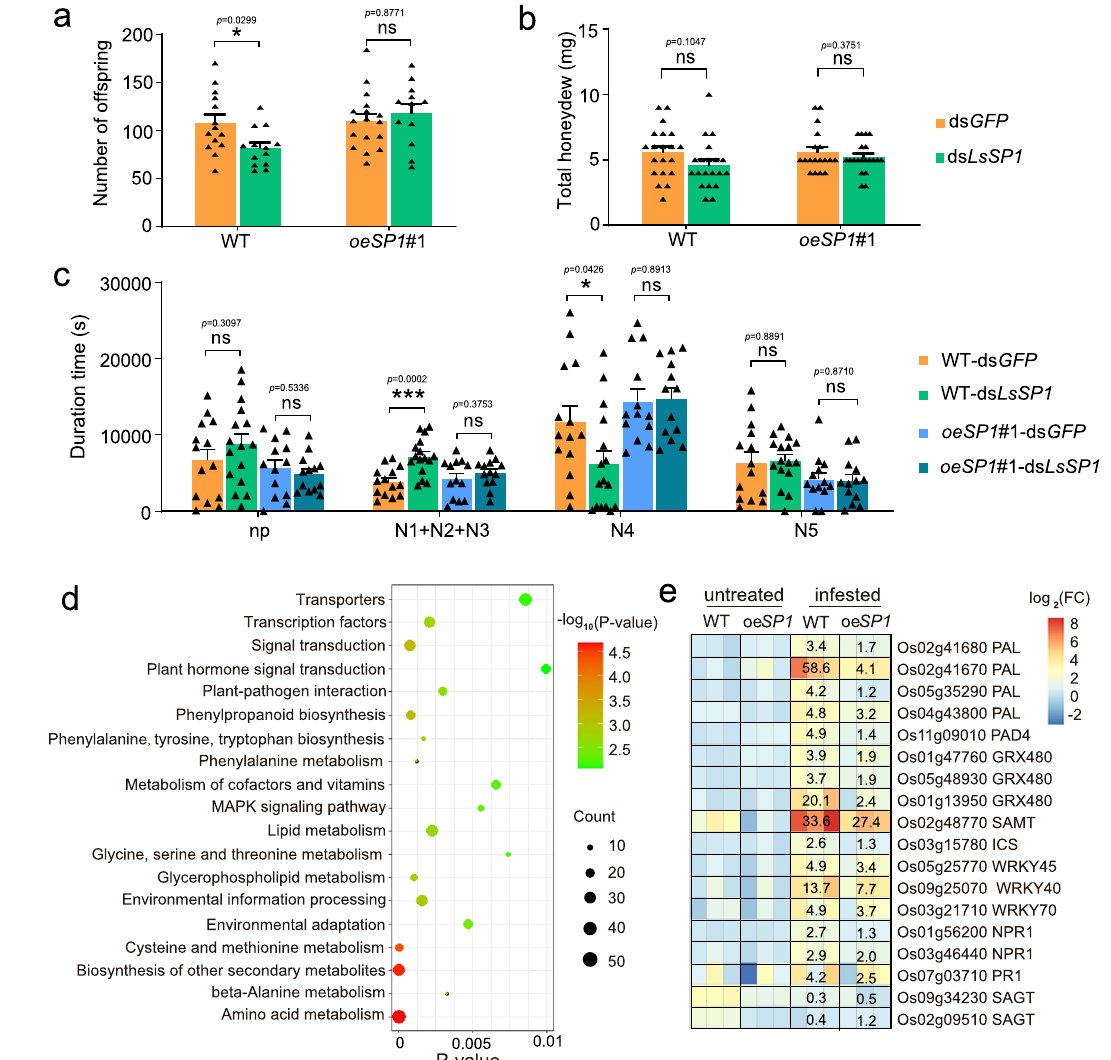
Genomes(KEGG)pathwayenrichmentanalysisofDEGsspeci fi callyidenti fi edinWT plants, but not in oeSP1 #1 plants. Enriched P -values were calculated according to one-sided hypergeometric test using TBtools software 70 . e The impacts of L. stria- tellus infestation onsalicylic acid (SA) markergenes in WT and oeSP1 #1plants. PAL phenylalanineammonialyase,PAD4phytoalexinde fi cient4,GRX480glutaredoxin GRX480, SAMT SA methyl transferase, ICS isochorismate synthase, WRKY tran- scription factor WRKY, NPR1 non-repressor of pathogenesis-related protein 1, PR1 pathogenesis-related 1, SAGT SA glucosyl transferase. Nipponbare rice plants and transgenic plants of Nipponbare background were used. Source data are provided as a Source Data fi